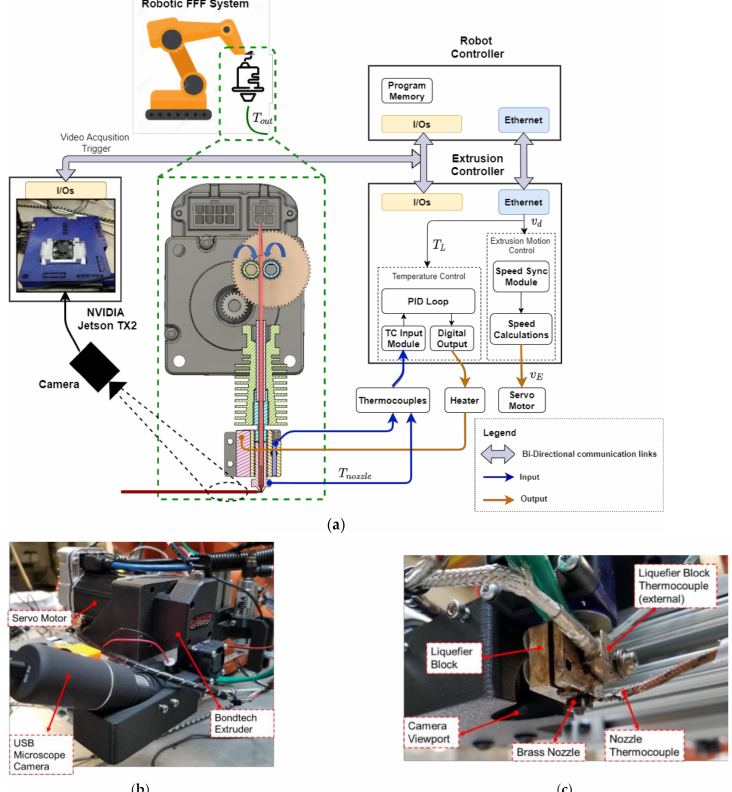
Figure 2. ( a ) Overview of architecture and signal flow for the robotic FFF testbed; ( b ) Updated robotic FFF extrusion system with Servo motor, Bondtech extruder, and USB microscope camera; ( c ) Closer view at the hot-end portion of the extruder showing the installed nozzle